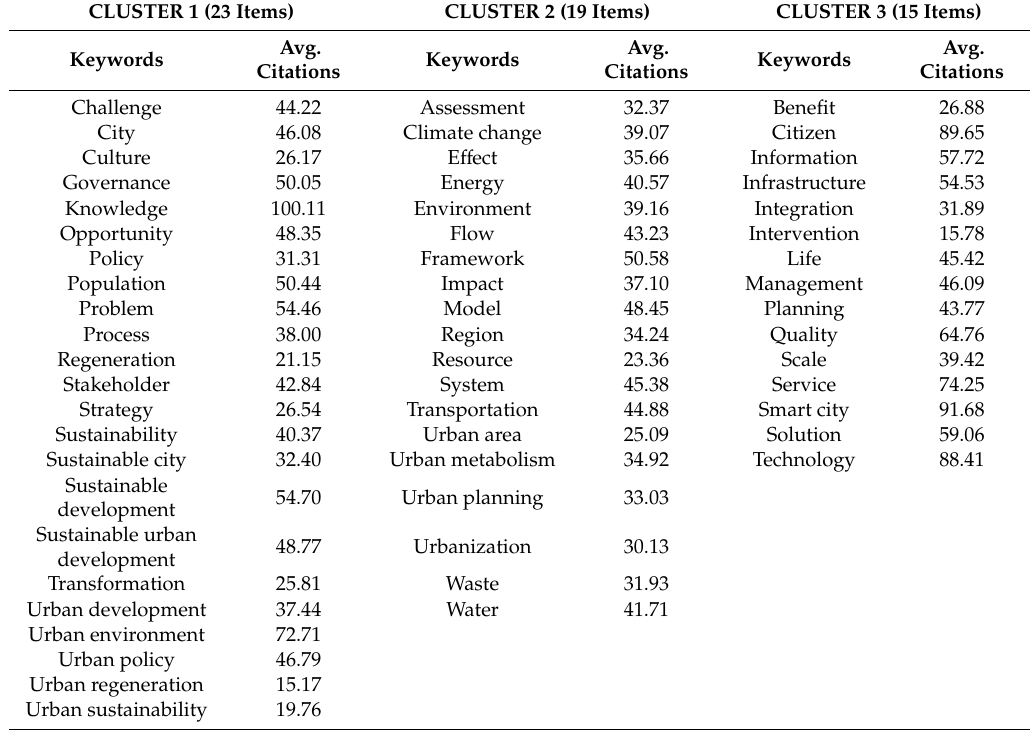
Table 3. Average citations of the selected keywords per clusters in co-occurrence